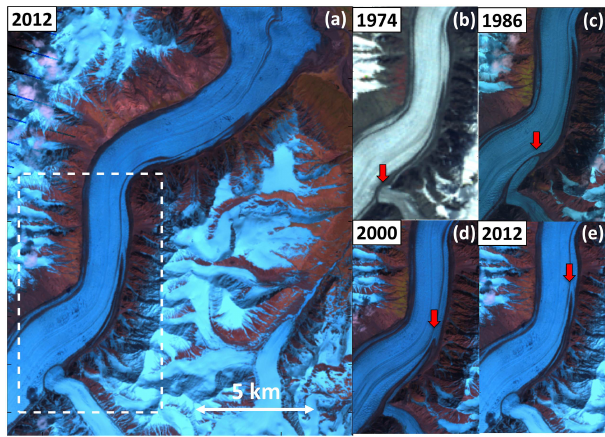
Figure 3. Spatial patterns of the looped moraines induced by the tributary surges shown in the Landsat images. (a) The near-terminus region of Donjek Glacier shown in Landsat 7 ETM + false colour composite image acquired on 6 June 2012. The white dotted box shows the enlarged areas shown in (b–e) . (b) Snapshot on 19 July 1974 of the moraine movements (red arrow) generated by the 1973–1974 tributary’s surge. (c) Same as (b) except 25 July 1986. (d) Same as (b) except 7 July 2000. (e) Same as (b) except 6 June